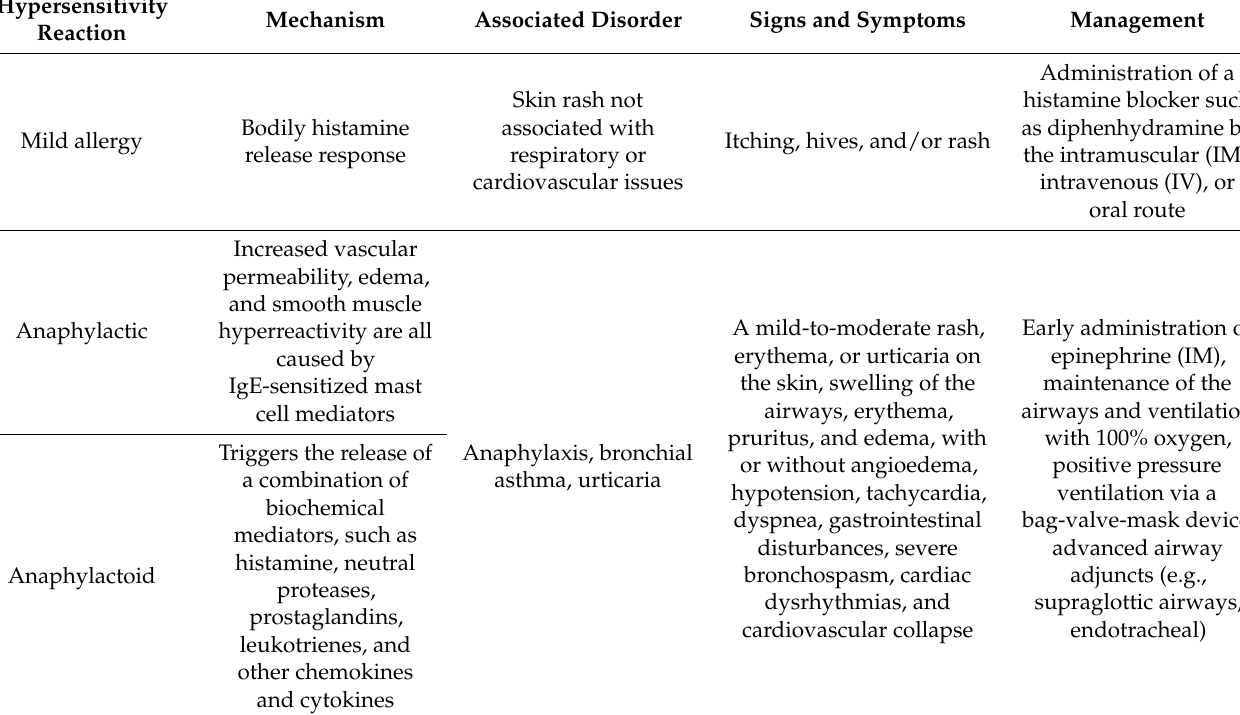
Table 3. Several forms of hypersensitivity reactions accelerated by local anesthetics and their management [48,49]. Hypersensitivity